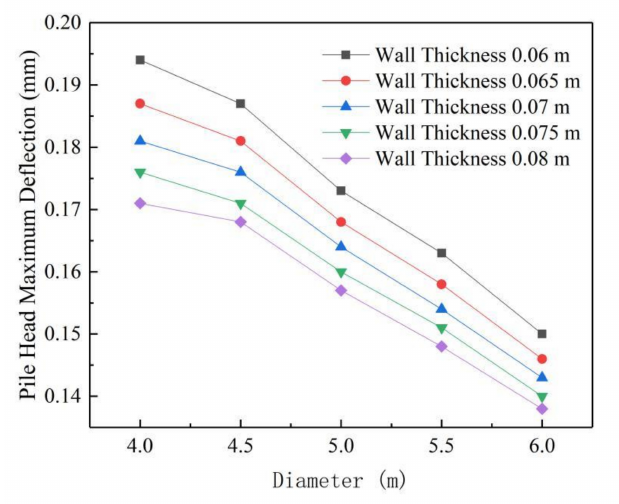
Figure 9. Influence of pile diameter and wall thickness on maximum deflection of pile head.